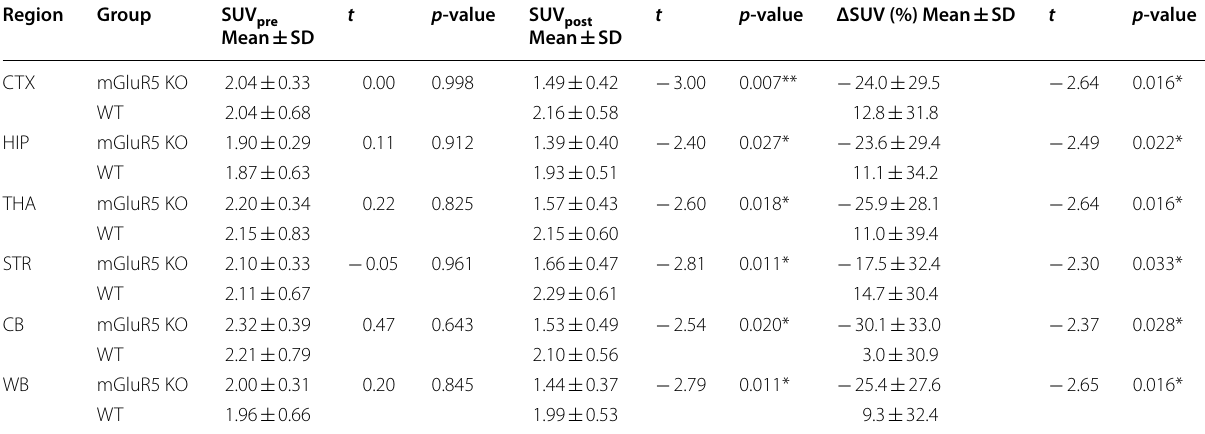
, SUV and ΔSUV with acute MK-801 challenge pre post